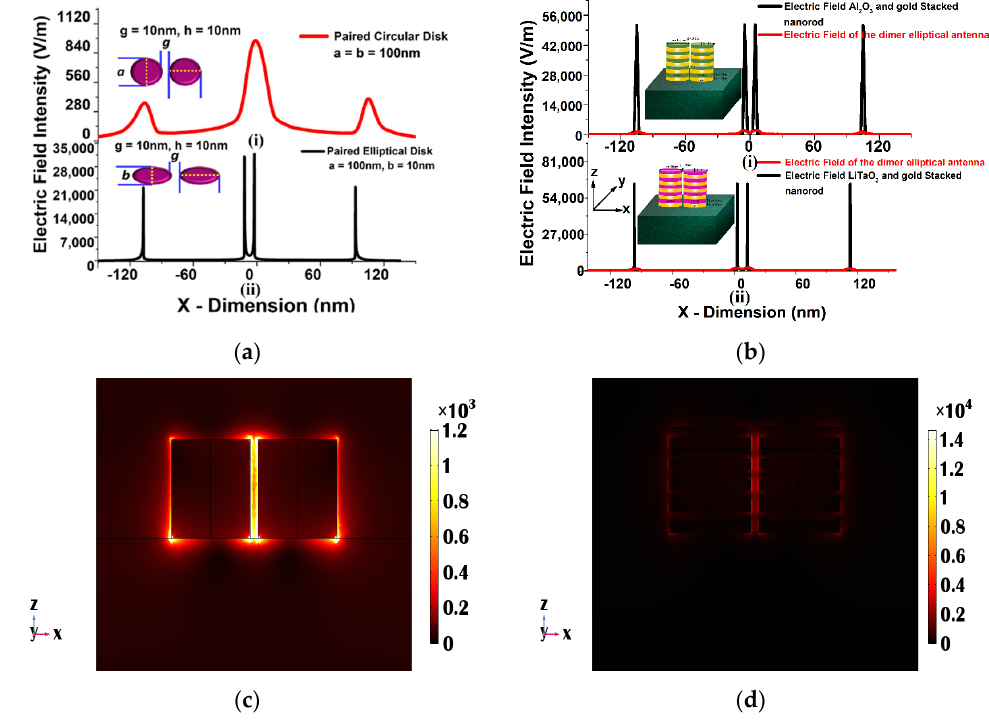
Figure 4. ( a ) Electric field distribution along the x plane in the gold elliptical and circular paired structure when a = 100 nm, b = 10, g = 10 nm and h = 10 ( b ) Electric field distribution along the x plane in the single gold and stacked 10 layers (with LiTaO 3 or Al 2 O 3 ) elliptical paired structure when a = 100 nm, b = 10, g = 10 nm and h 1 = h 2 = 10 nm. ( c ) E y , mode field profile at 940 nm wavelength of a single metallic elliptical nano structure when a = 100 nm, b = 10 nm, and h = 100 nm along the x-z plane ( d ) Electric field variation at 1000 nm wavelength along the x-z plane for a 10 layered LiTaO 3 stacked nano structure when a = 100 nm, b = 10 nm, and h 1 = h 2 = 10 nm.